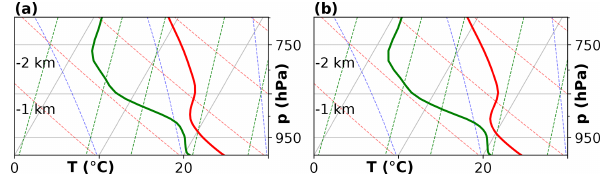
Figure 22. Profiles of the skewed temperature (solid red line) and dew point temperature (solid green line) against the pressure (hPa). The profiles for cy40REF (a) and cy40NEW (b) are deter- mined as the average over the domain indicated by the rectangle in Fig. 21, where a strong shower did develop in cy40NEW but not in cy40REF. Dashed red, blue, and green lines show, respectively, the dry adiabat, the pseudo adiabat, and constant mixing ratio. Skewed thin grey lines represent constant temperature. In comparison with cy40REF, cy40NEW reveals a stronger inversion around the top of the boundary layer (approximately 1000m